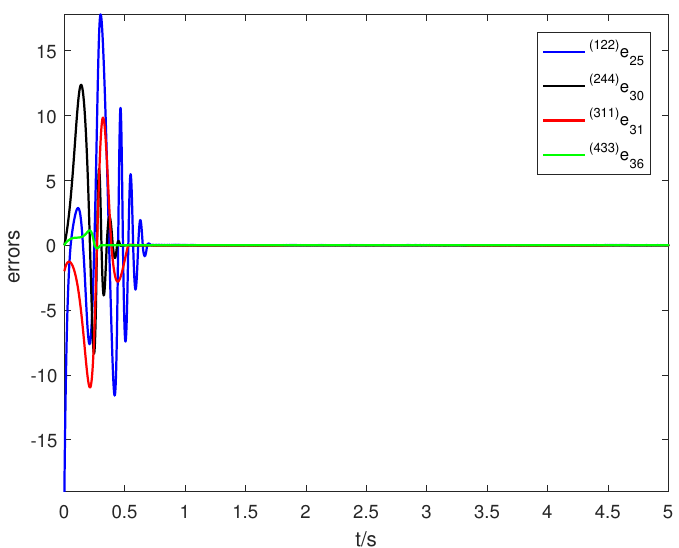
Figure 6. The synchronization errors ( 122 ) e 25 , ( 244 ) e 30 , ( 311 ) e 31 , ( 433 ) e 36 change with time t .